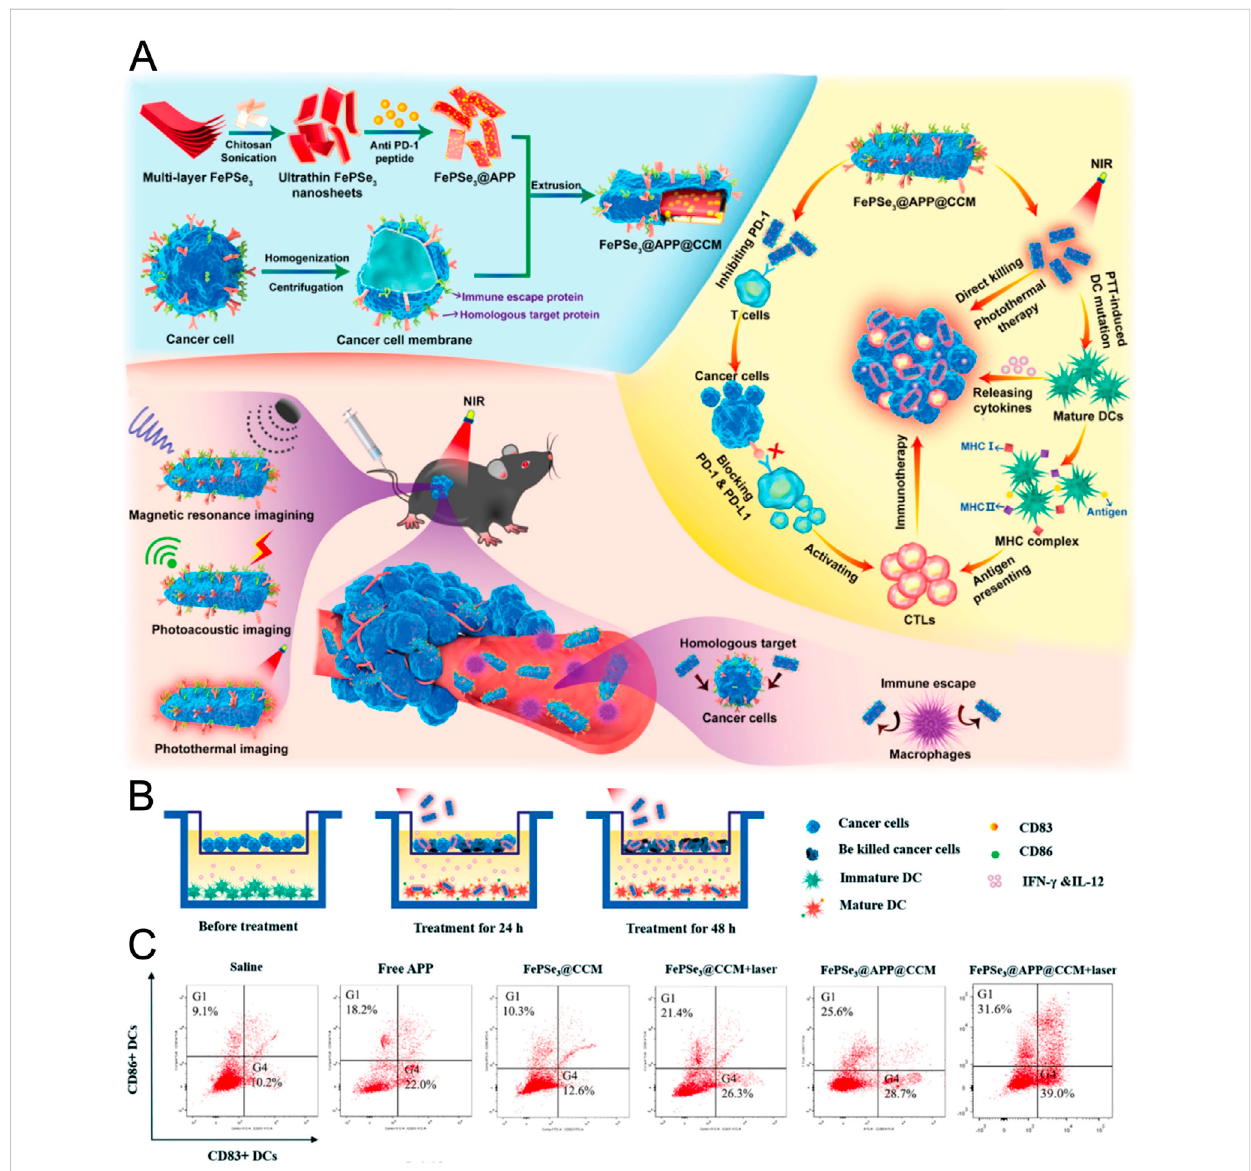
FIGURE 4 (A) Schematic illustration of fabrication of FePSe 3 @APP@CCM and the strategy of combined PTT immunotherapy. maturation during the treatment. (C) Flow cytometry analysis of DC maturation in different groups. (Adapted with permission from Fang et al.,